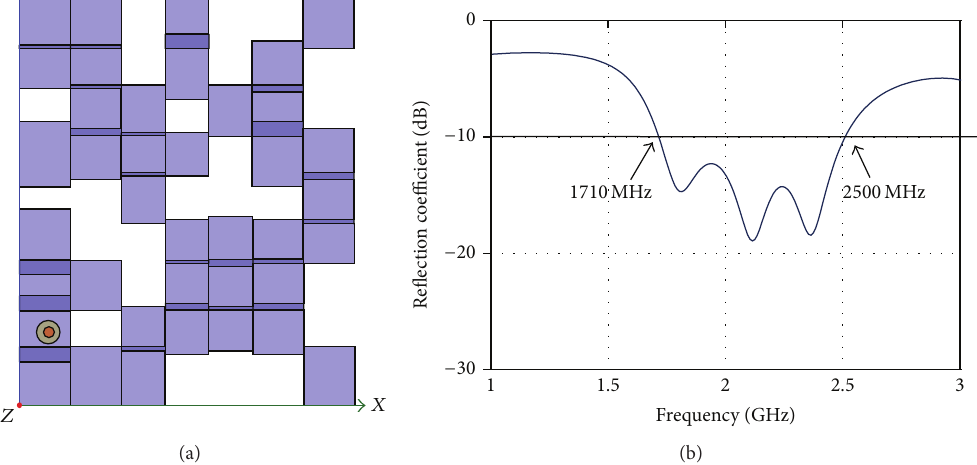
Figure 5: The optimized MPA with nonuniform overlaps. (a) Optimized design. (b) Reflection